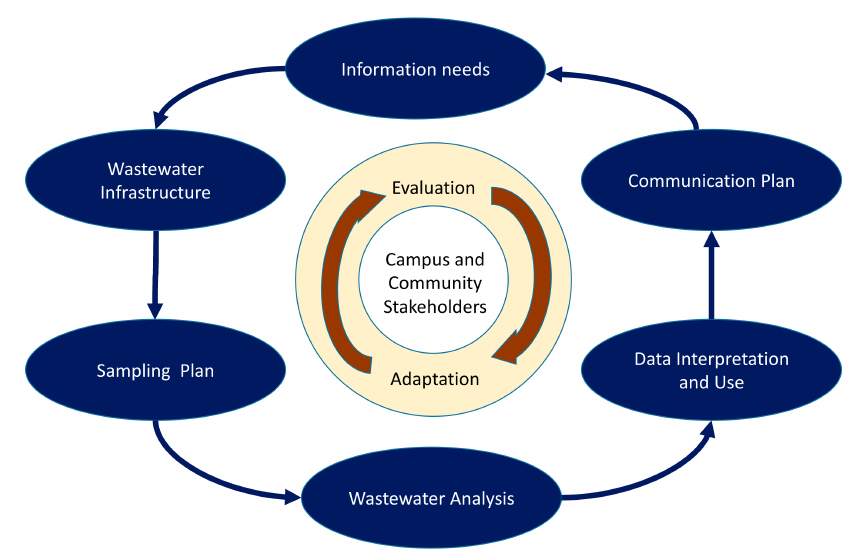
Figure 3. An iterative, process-oriented framework for wastewater surveillance at colleges. Table 3. A framework for designing a campus wastewater monitoring